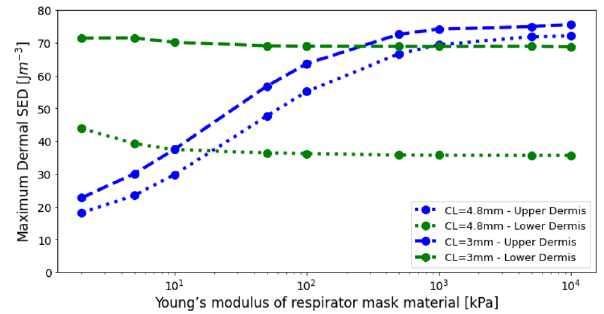
Figure 3. Evolution of SED in the tissue as a function of mask material modulus for contact lengths of 4.8 mm and 3 mm. Changes in contact length had a substantial effect on maximum SED in the lower dermis compared to the upper